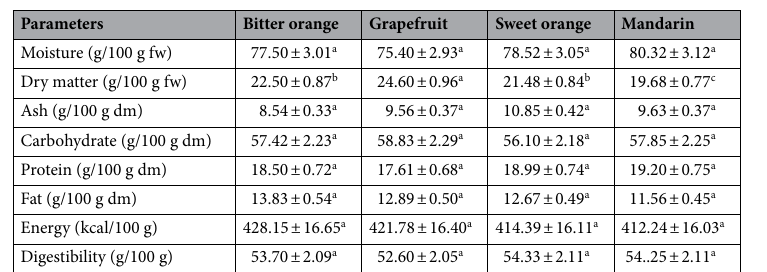
Table 1. Biochemical composition of bitter orange, sweet orange, grapefruit, and mandarin peels. The values are expressed as means ± SD for three replicates experiments. Mean values with similar letters within a row are statistically similar, while mean values with different letters within a row are significantly different by the Tukey test ( P < 0.05). fw fresh weight, Dm dry matter.